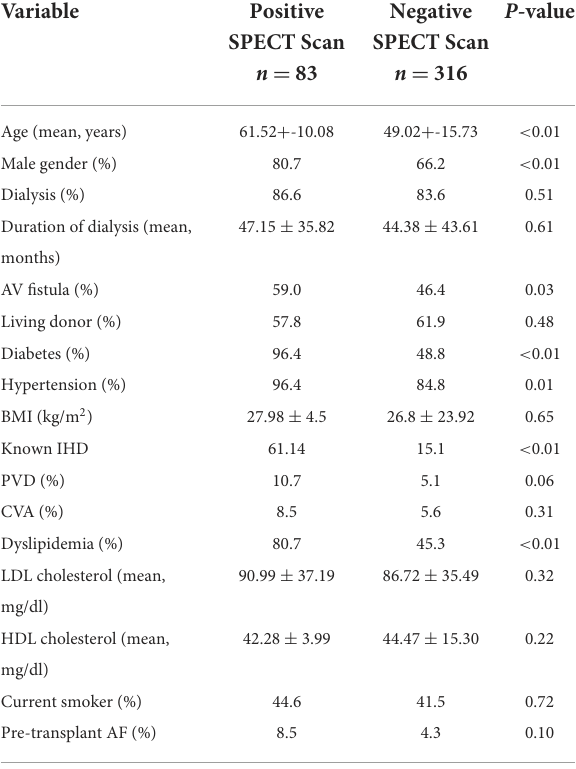
TABLE 3 Baseline characteristics of patient groups according to SPECT scan